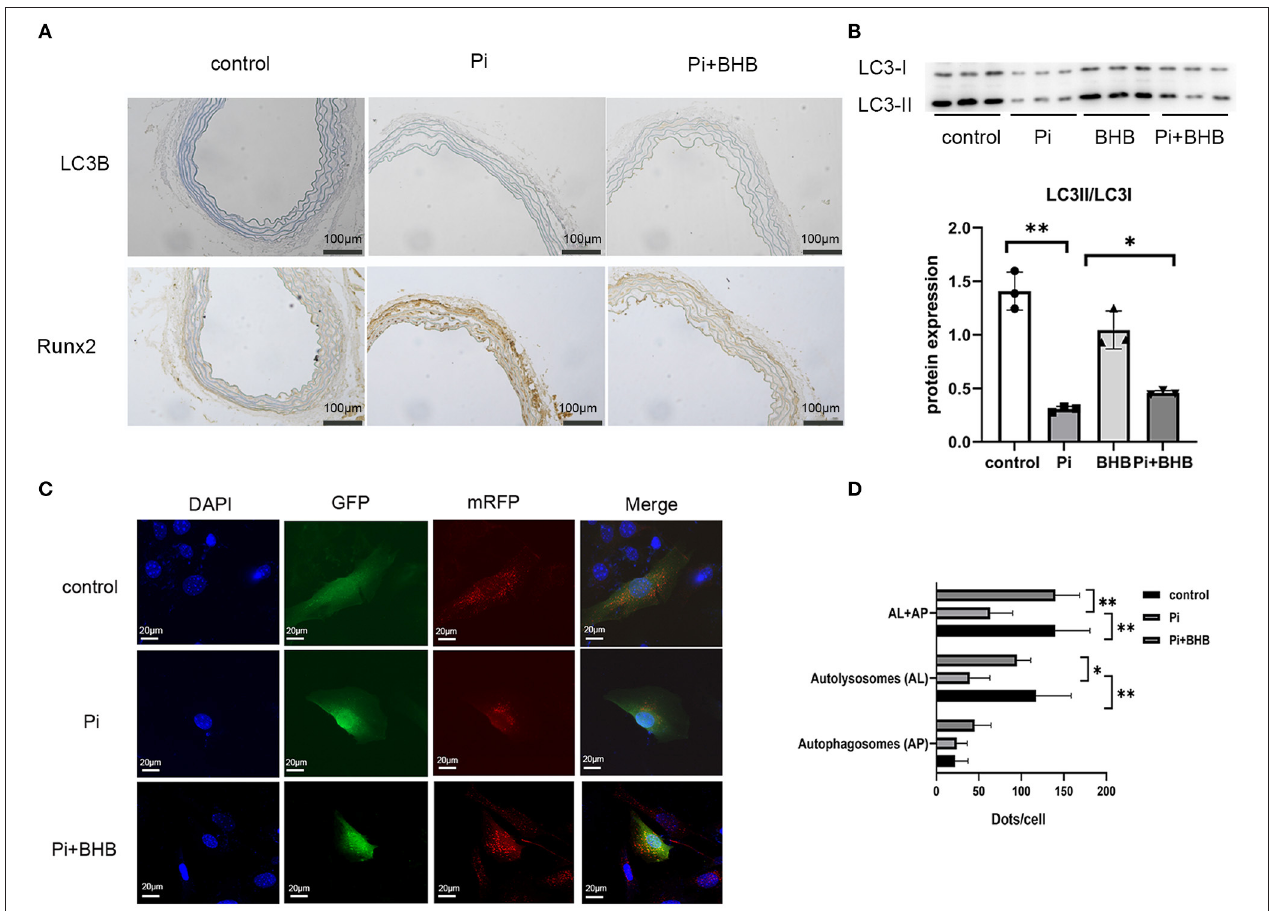
FIGURE 4 | β -Hydroxybutyric acid-enhanced autophagy. (A) Immunohistochemical analysis detected the expression of LC3B and Runx2. Scale bar: 100 µ m. (B) Representative Western blot bands and semi-quantitative analysis of LC3II/LC3-I. (C,D) Representative confocal images (scale bar, 20 µ m) and quantitative analysis of mRFP-GFP-LC3 puncta in vascular smooth muscle cells. The bar graph shows the mean number of autophagosomes (yellow dots) and autolysosomes (red dots) per cell. N = 5 per group. * P < 0.05; ** P <